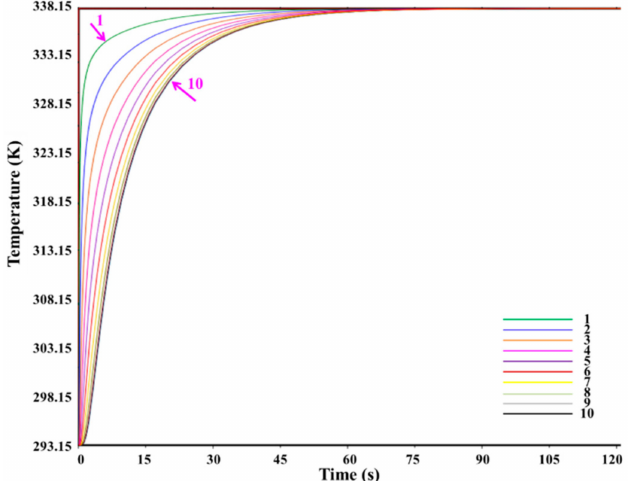
Figure 5. Change of temperature with time at 10 points along the arrow indicated in Figure 4, where 1 is closest to the heating surface and 10 is farthest from the heating